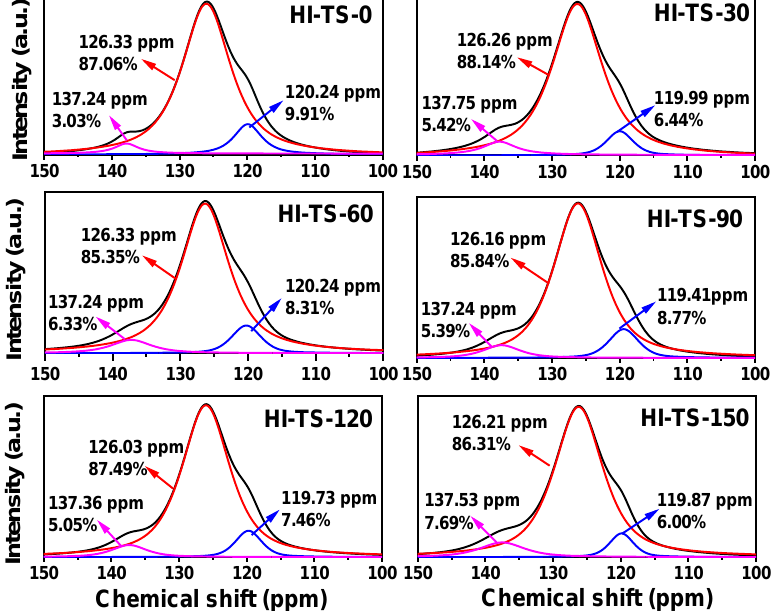
Figure 6. The classification of aromatic carbon in the HI − TS fraction.